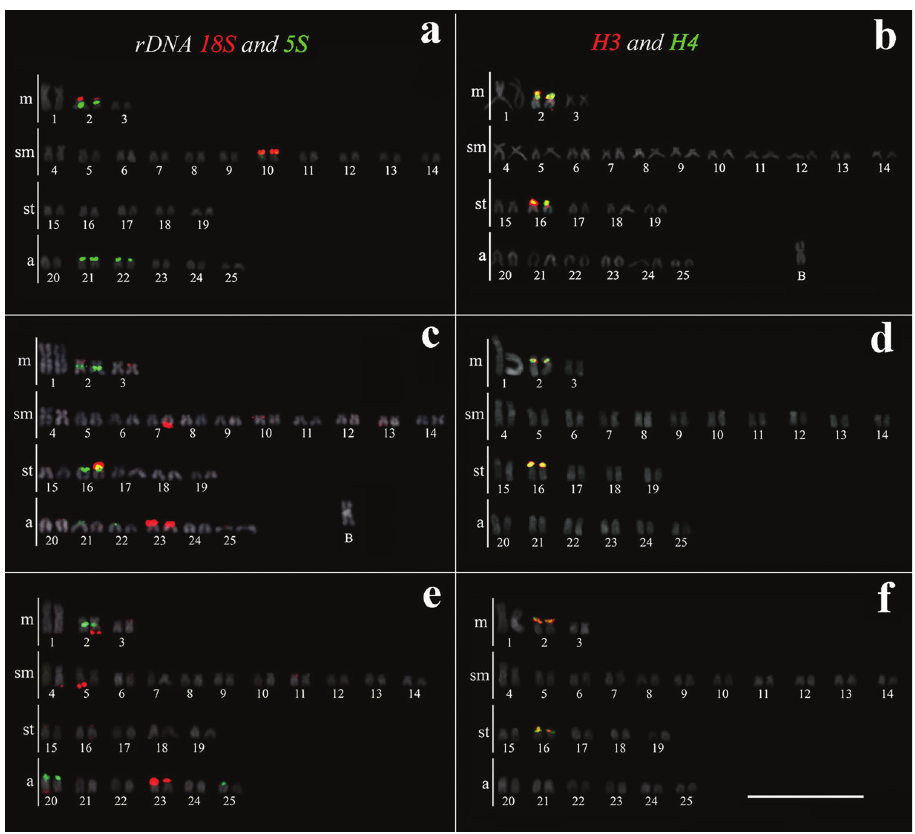
Figure 1. Karyotype of the three Astyanax scabripinnis populations ( a , b Lavrinha Farm Stream – LSF); ( c , d Lake of Pedalinho – LP); ( e , f Ribeirão das Perdizes – RP). In a , c , e are visualized signals of 18S (red) and 5S (green) with rDNA probes and in b , d , f H3 (red) and H4 (green) with histones probes, after double Fluorescence in situ Hybridization (FISH), respectively. Scales bar: 10